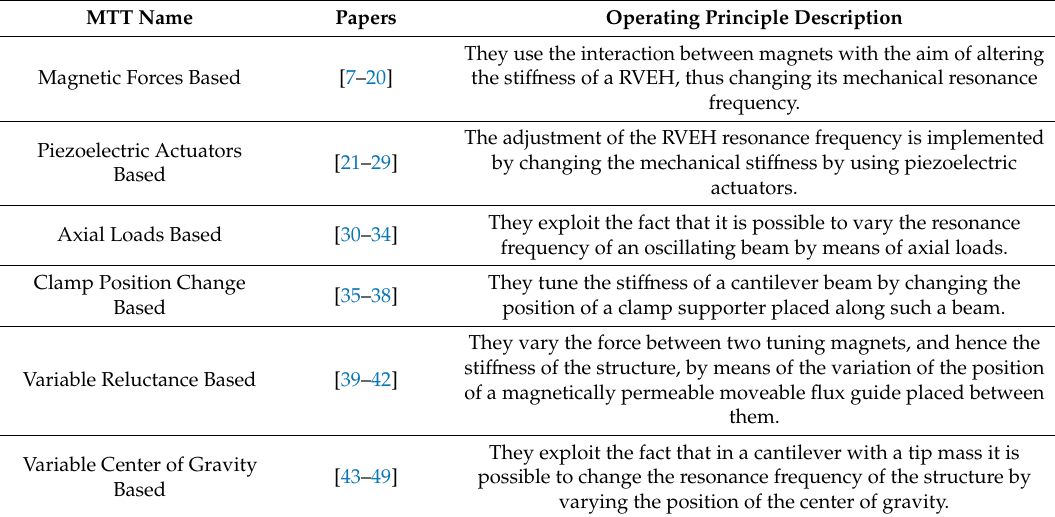
Table 1. Main types of MTTs proposed in the literature, grouped by operating